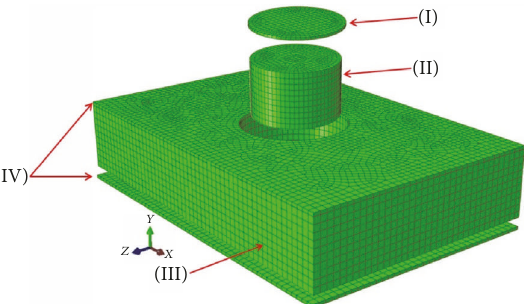
Figure3:A3Dfiniteelementmodelofsandwichplatewithapenny- shaped debonded region